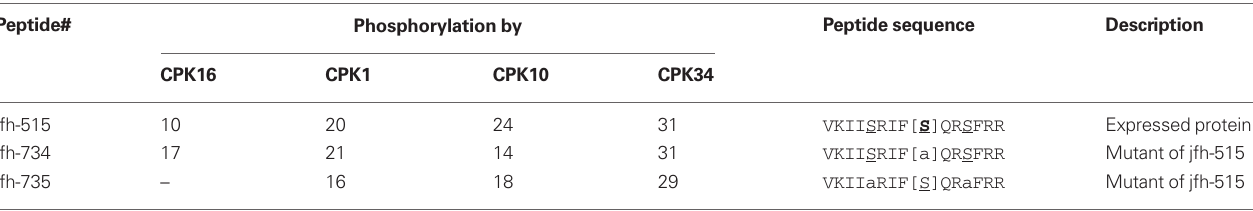
Table 3 | “Peptide mapping” of phosphorylation sites in substrate jfh-515 provides evidence for a substrate specificity difference between CPK16 and CPKs 1, 10, and